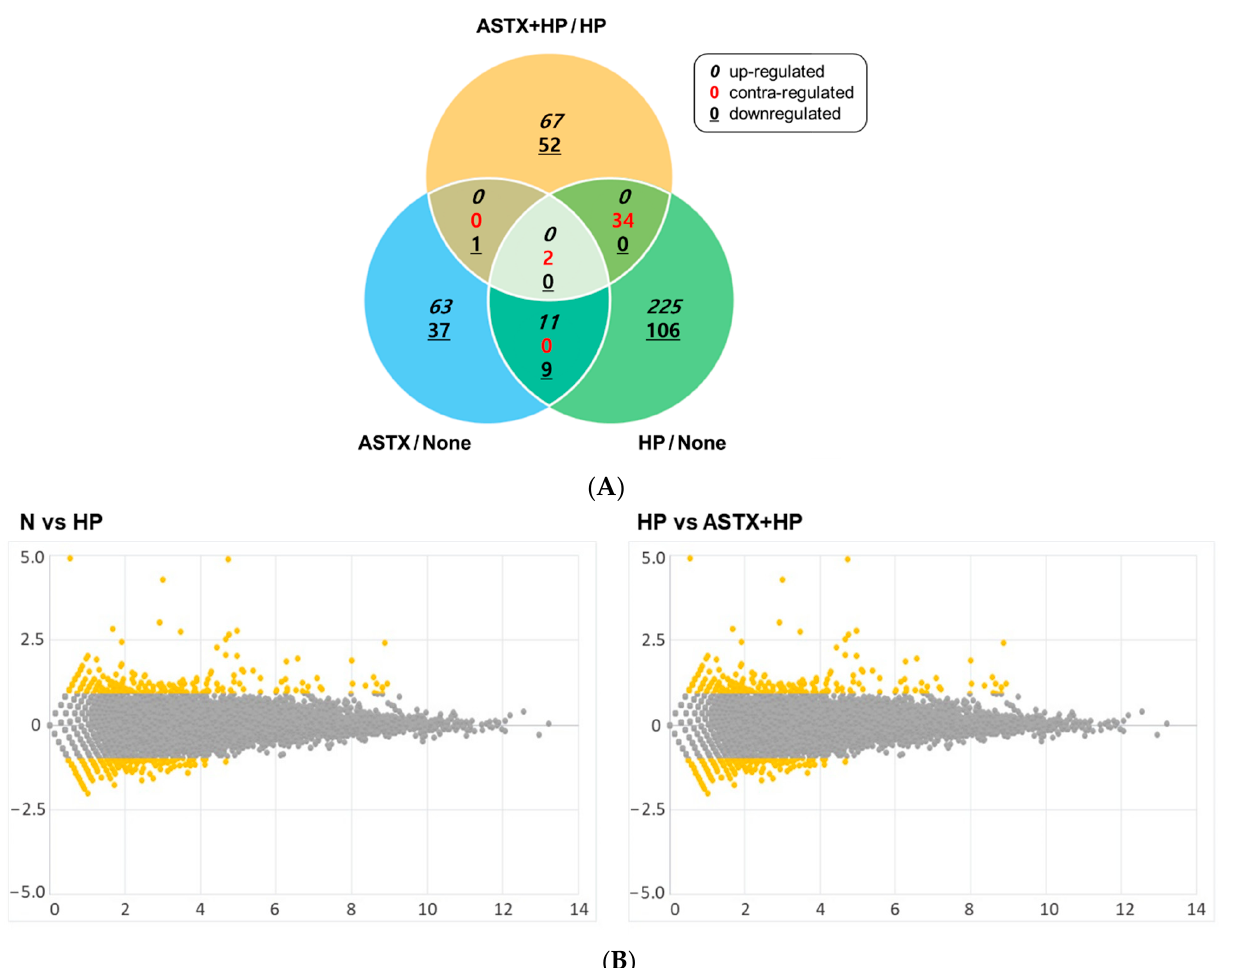
Figure 1. A comparison of differentially expressed gene (DEG) expression pattern observed between pairs, and paired-pairs, of the four experimental groups of uninfected AGS cells (N or None), AGS cells infected with H. pylori (HP), AGS cells treated with astaxanthin (ASTX), AGS cells treated with astaxanthin and infected with H. pylori (ASTX+HP). ( A ) The Venn diagram summarizes the number of DEGs in each experimental pair. Numbers in black italic font correspond to upregulated DEGs, underlined numbers correspond to downregulated genes, and numbers in red correspond to genes that are upregulated in one set of experimental group and downregulated in the other. ( B ) The MA plots visualize differences in gene intensity value between each experimental pair. The log2 fold changes of all genes were plotted against the mean normalized expression counts. Genes with a fold change >1.5 (shown in yellow) were considered differentially expressed. The y-axis represents log2 fold changes, where positive values (0 < y < 5) indicate upregulated gene expressions and minus values ( − 5.0 < y < 0) indicate downregulated gene expressions. Without the hyphen: upregruated.